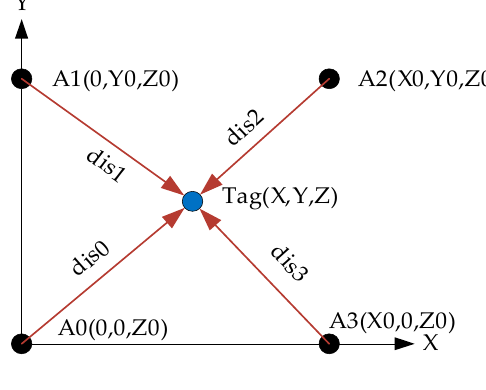
Figure 10. The placement of base stations and the tag.